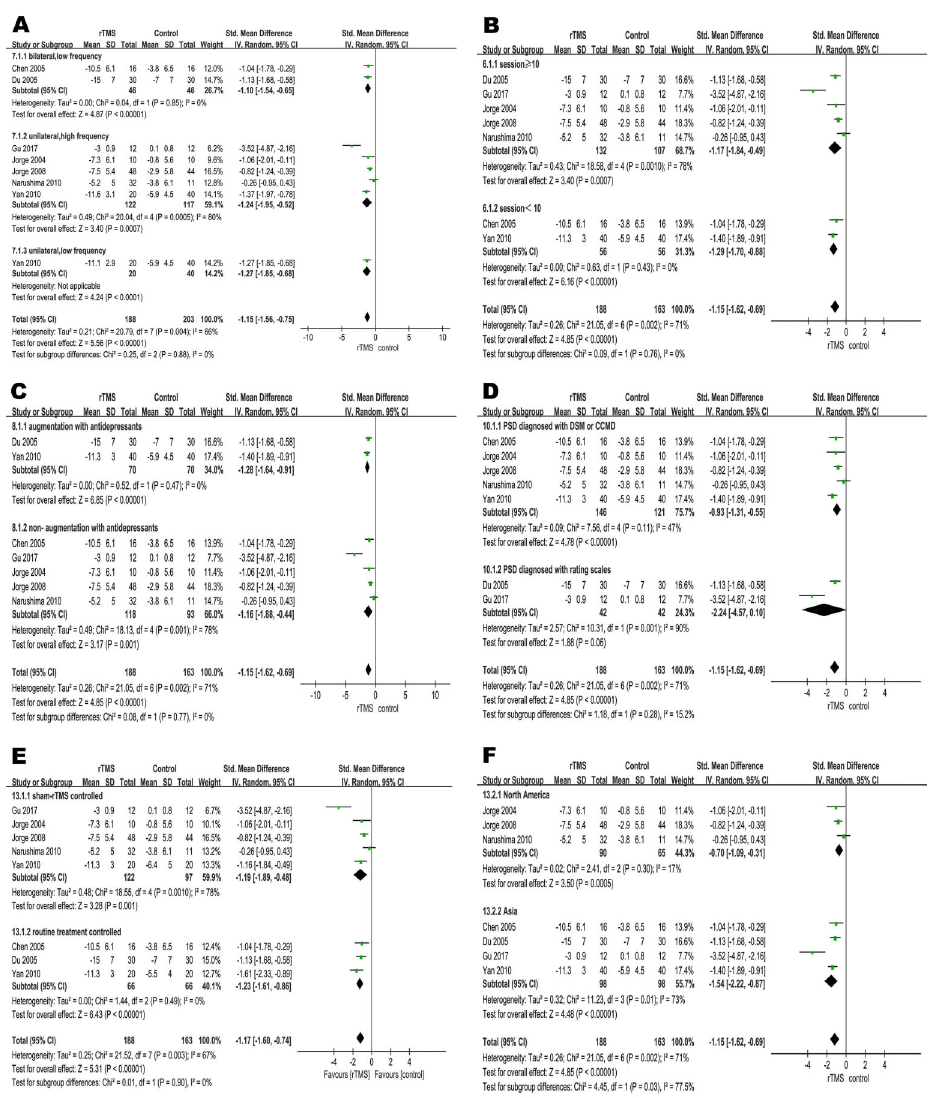
Figure 4. Subgroup analyses of repetitive transcranial magnetic stimulation (rTMS) and control conditions for ef fi cacy. A , Forest plot of standardized mean difference (SMD) for change in scores in rating scales for stimulation pattern; B , treatment sessions; C , augmentation with antidepressants; D , depression diagnosis criteria; E , for control conditions; F , study region. See Table 1 for corresponding numbers of